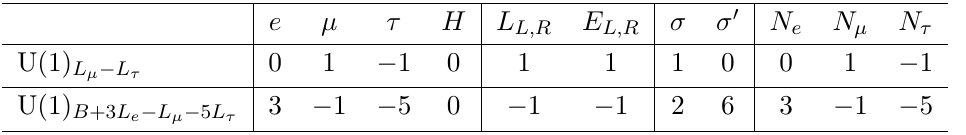
and U(1) B +3 L symmetries to the fields µ − L τ e − L µ − 5 L τ